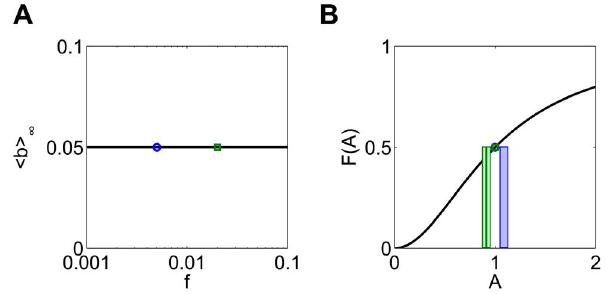
Figure 5. Duration compensated signals yield a flat frequency response in the b-model. ( A ) The flat frequency response. ( B ) Since the amplitude is fixed for all frequencies for duration compensation, doubling the frequency of an initial signal leads to production of b at the high frequency (green bars) that exactly matches the production caused by one pulse at the low frequency (blue bar). A 0 =1, d 0 =10, and T 0 =100.